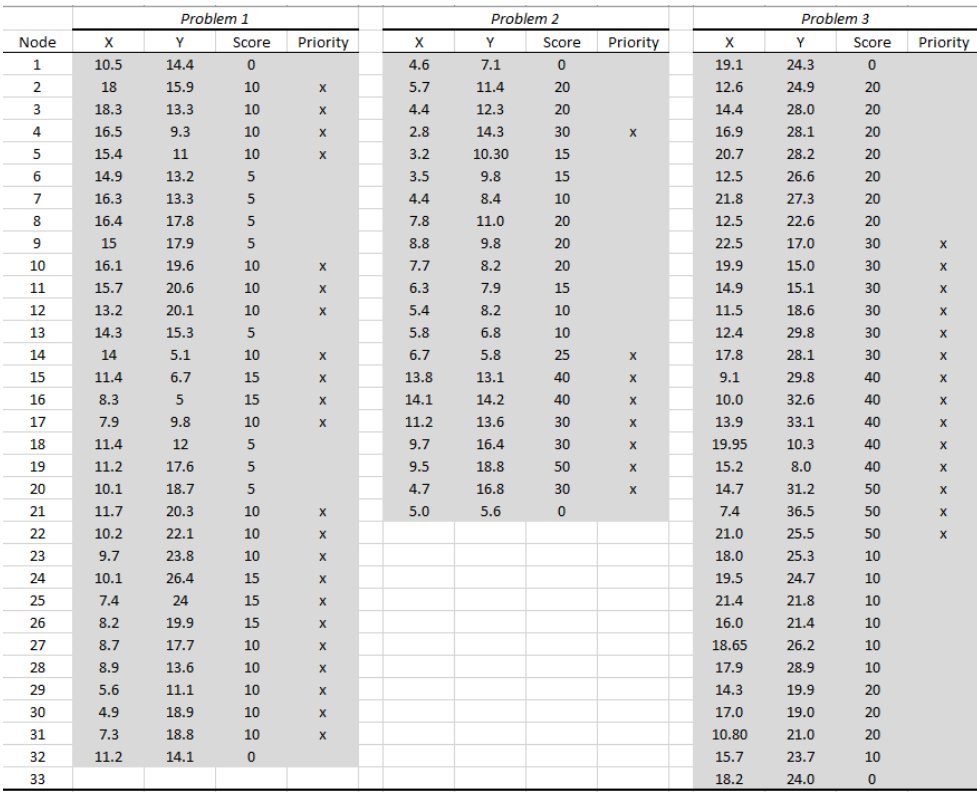
Figure 6. The benchmark data